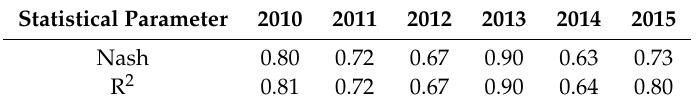
Table 2. Nash Sutcli ff coe ffi cient (Nash) and regression coe ffi cient R 2 for model calibration of daily discharge in the Tikur-Wuha watershed from 2010 to 2015. Each year was calibrated separately.